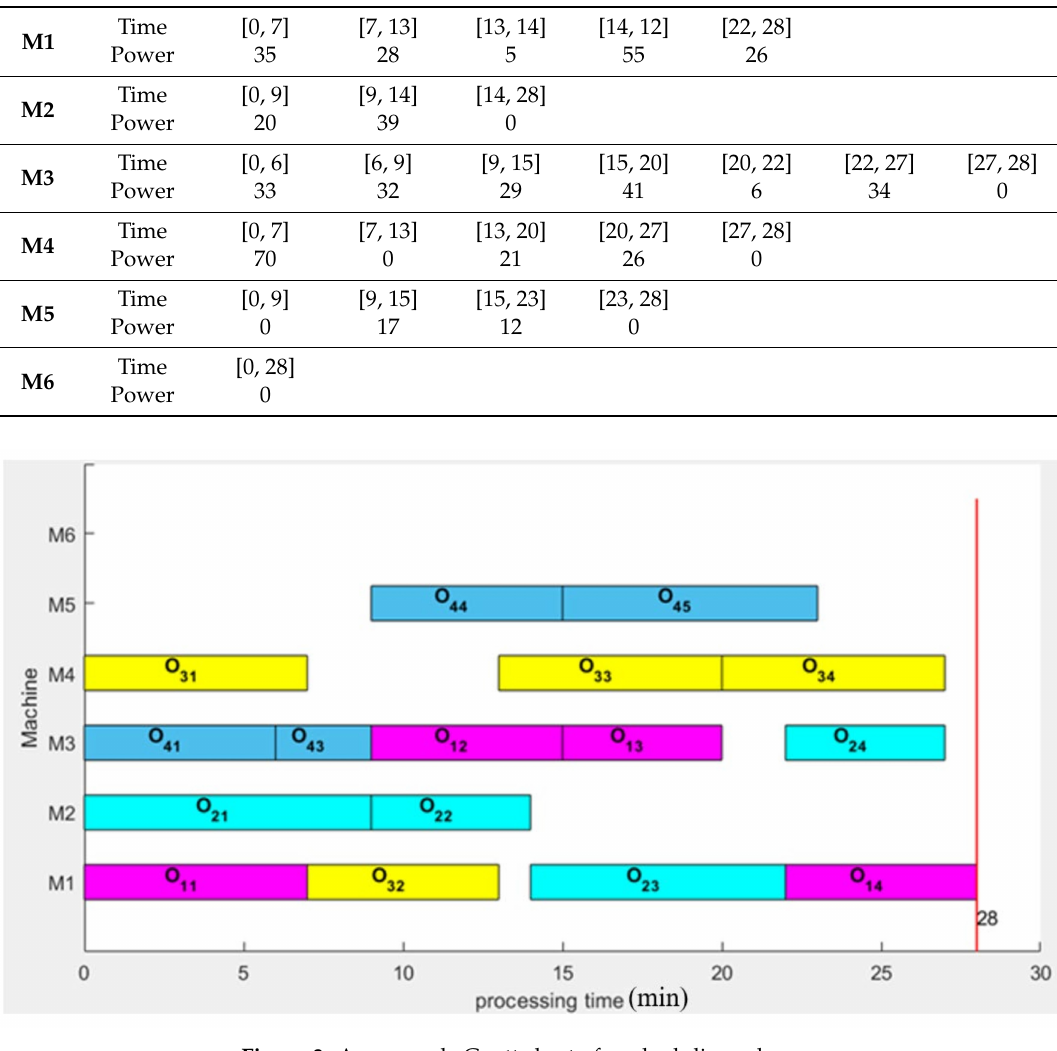
Figure 3. An example Gantt chart of a scheduling